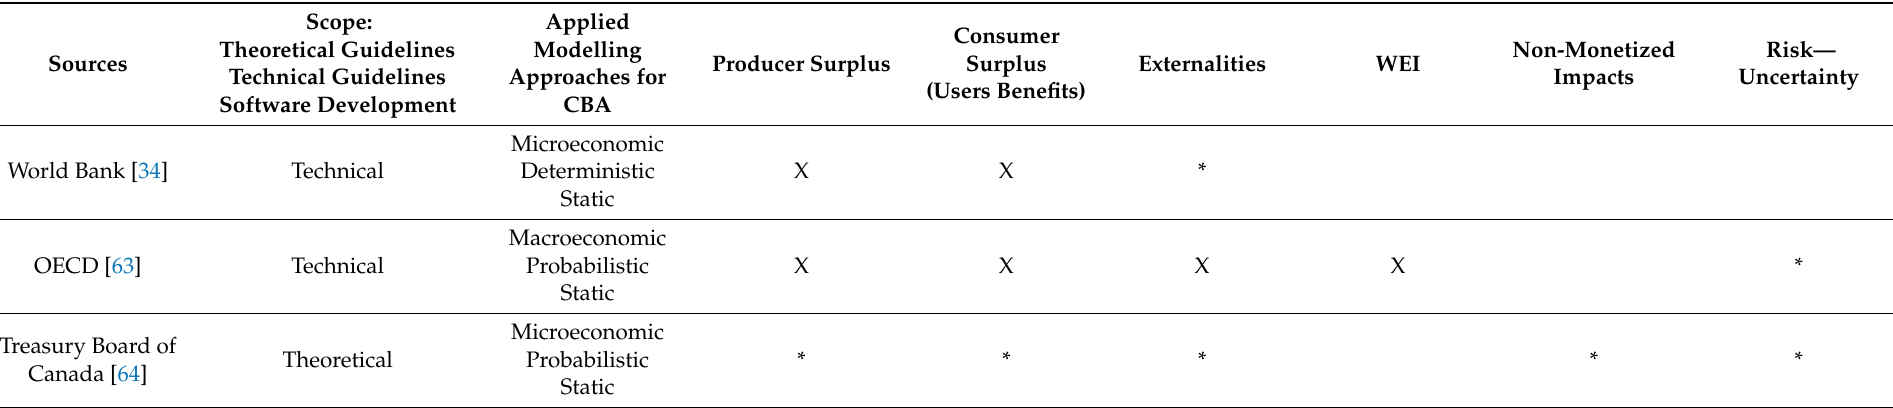
Table 3. Overview of the grey literature extracted from Google Scholar (GS) for CBA in the road infrastructure